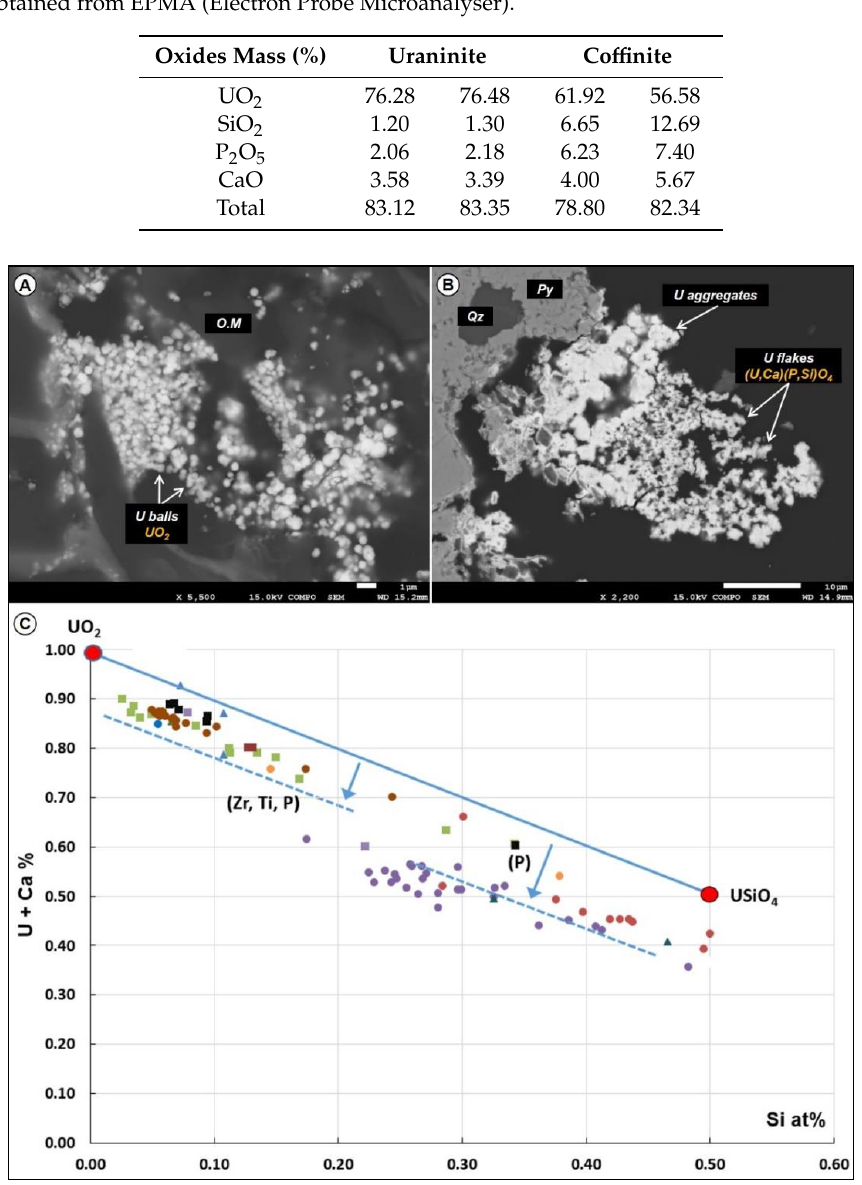
Figure 4. ( A ) SEM images of uraninite (U spheres) associated with organic matter and ( B ) Ca-P-coffinite (U flakes) associated with pyrite. Aggregates of both U minerals are also indicated. ( C ) Binary